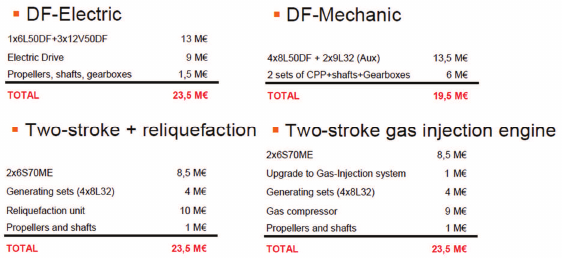
Fig. 6. Examples of engine prices [8]